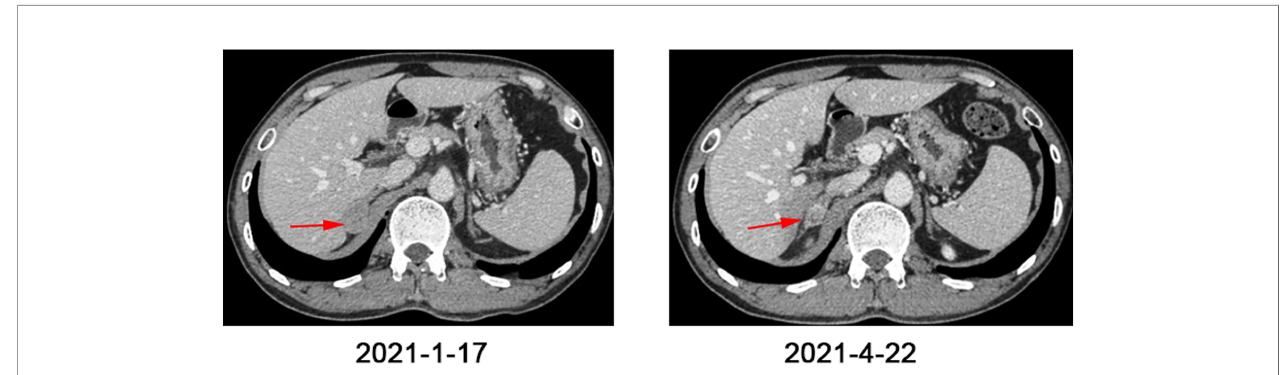
FIGURE 3 | Abdomen CT scans before and after one cycle of triple-combination therapy and two cycles of sintilimab treatment.